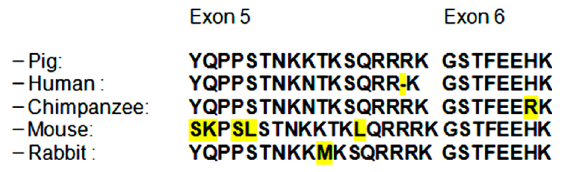
Figure 2. Peptide sequences of MGF in different species. MGF sequences are highly conserved and always consist of 25 amino acids with the exception of the human MGF peptide, which consists of only 24 amino